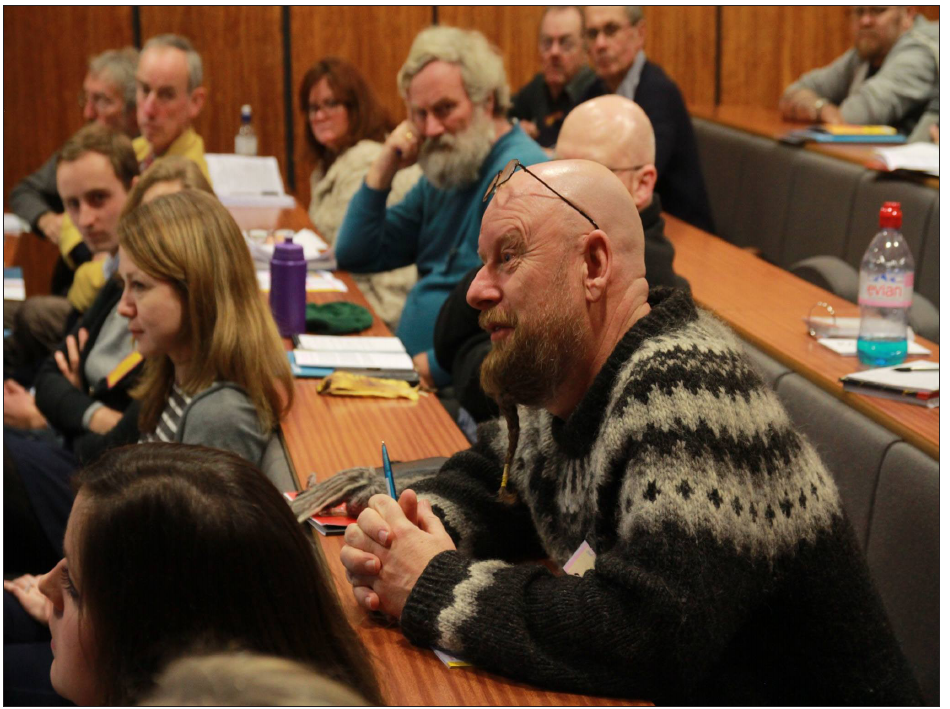
Figure 1: Dr. Mike Copper from Bradford University, one of the founders of NEBARSS, poses a question to Professor Mike Parker Pearson (Photo credit: Muyang